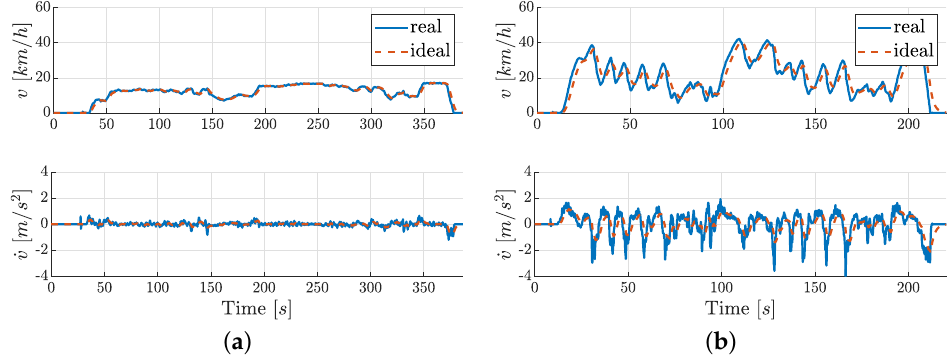
Figure 3. Ideal and real vehicle speed (and its derivative) in eco (upper plot) and non-eco tests (lower plot). ( a ) Eco driving test. ( b ) Non-eco driving test.